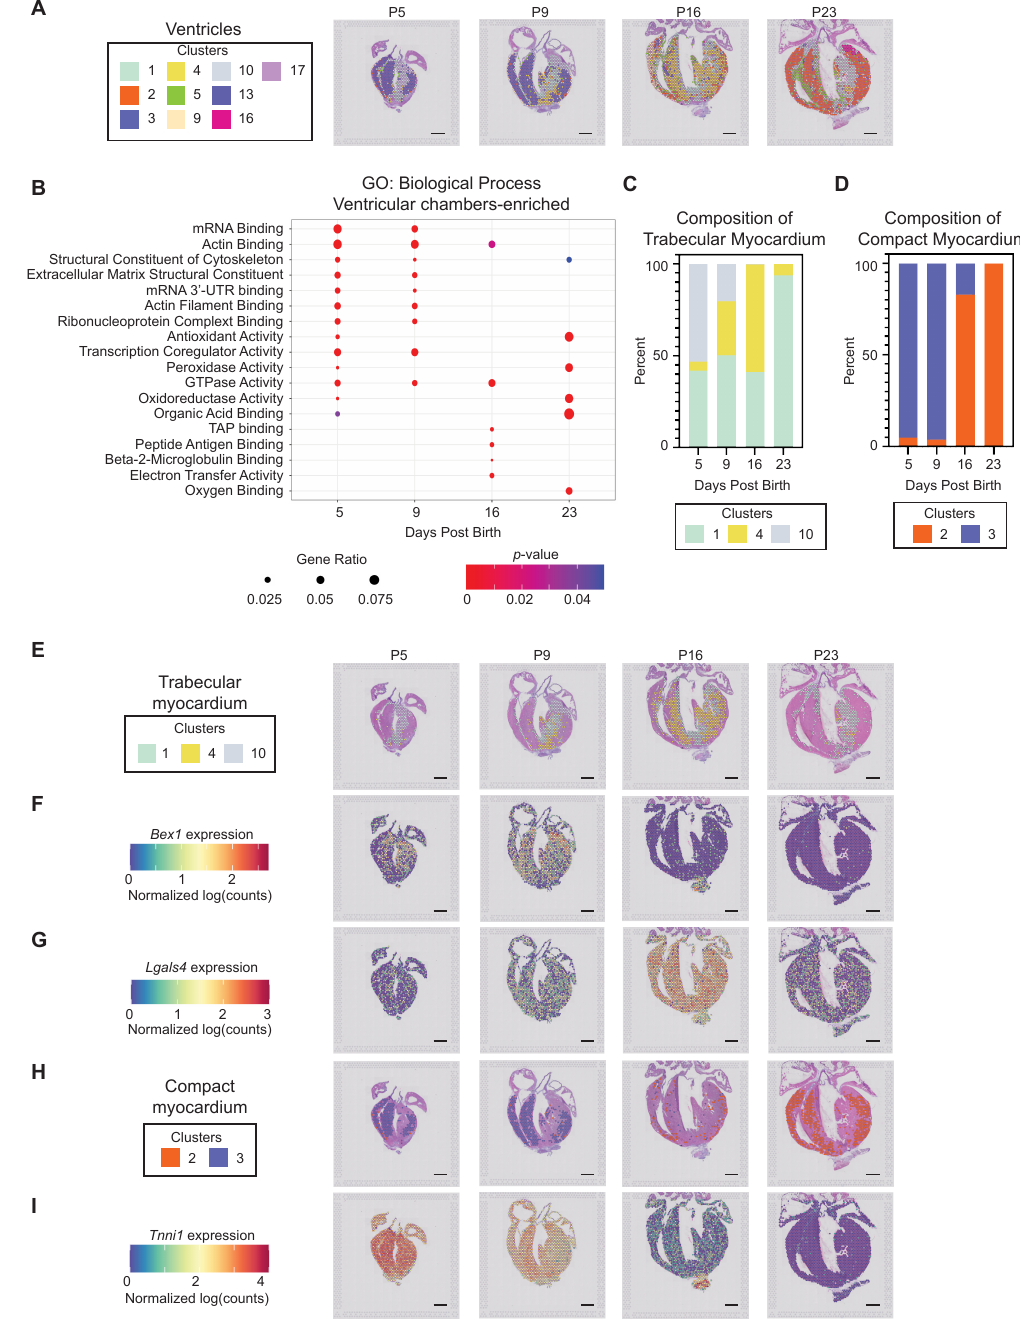
Figure 5. Spatially resolved transcriptional programs define trabecular and compact ventricular